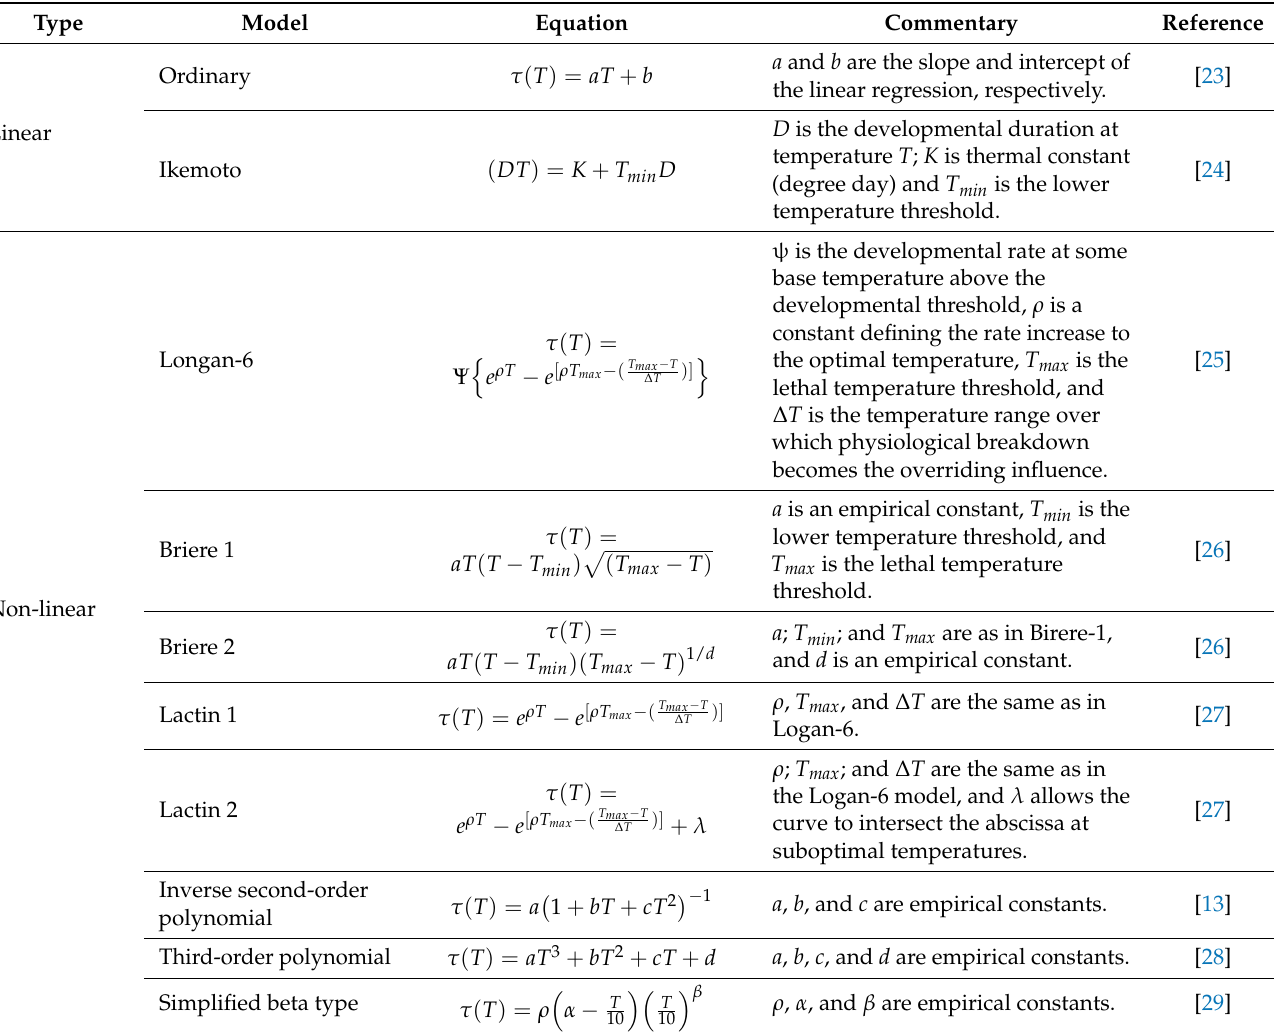
Table 1. Models used to analyze the relationship between temperature and development rate of the post-diapause period of Eurytoma maslovskii